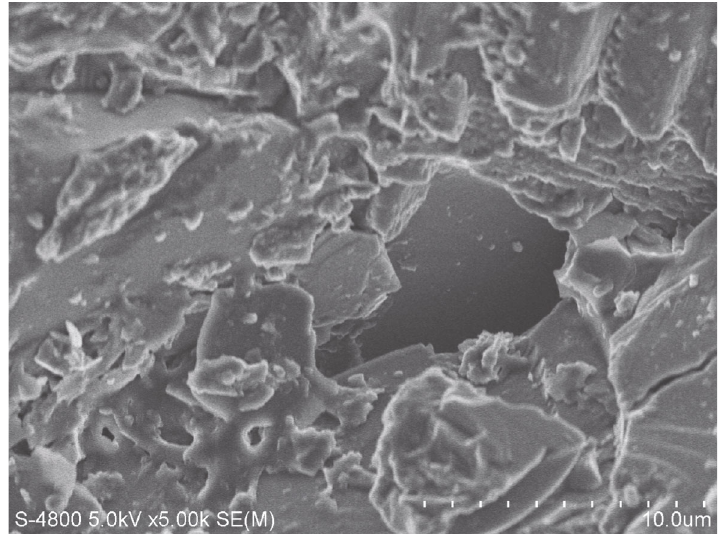
Figure 4: SEM results for granite with a magni fi cation of 5000x before F-T treatment.